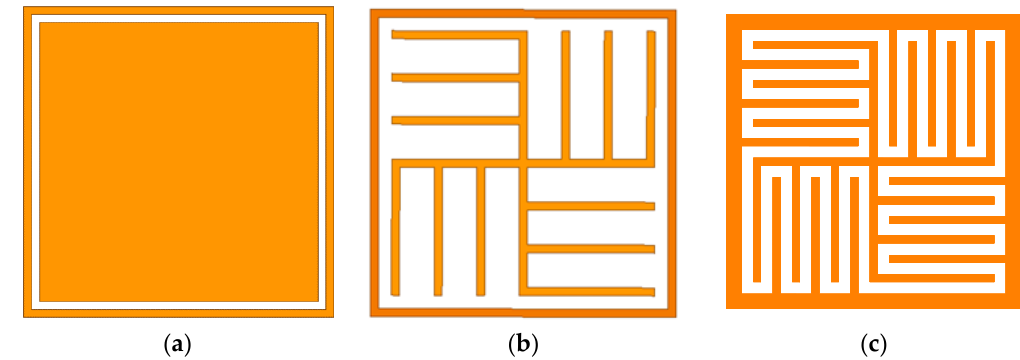
Figure 1. Design flowchart: ( a ) initial structure; ( b ) convoluted square stripes; ( c ) added branches to be convoluted and interdigitated stripe.